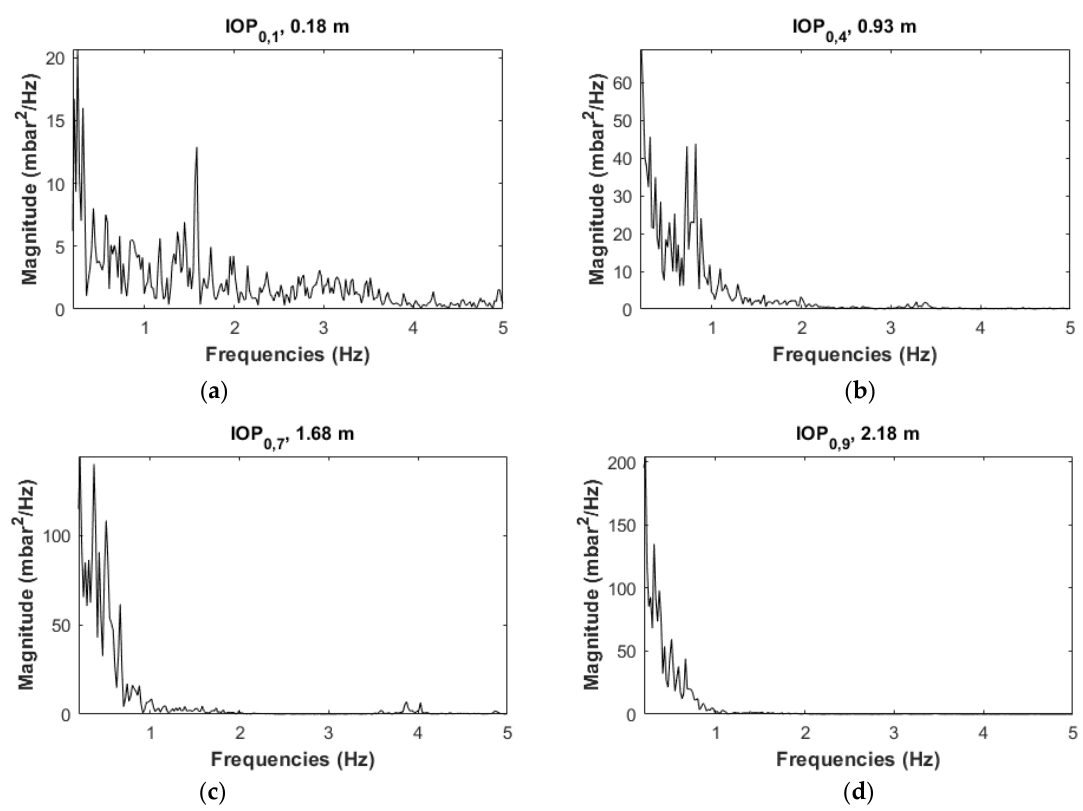
Figure 13. Four spectra obtained at various heights for the same experimental configuration, at U air − U mf = 0.36 m/s and G p = 56 kg/m 2 s: ( a ) 0.18 m, ( b ) 0.93 m, ( c ) 1.68 m and ( d ) 2.18